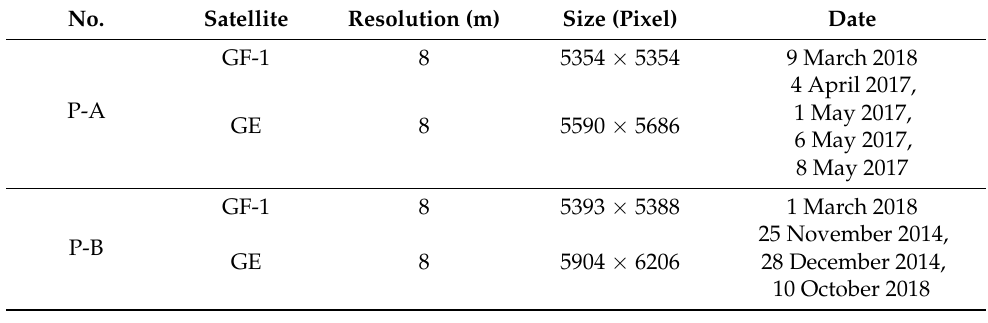
Table 2. Details of GaoFen multispectral images.